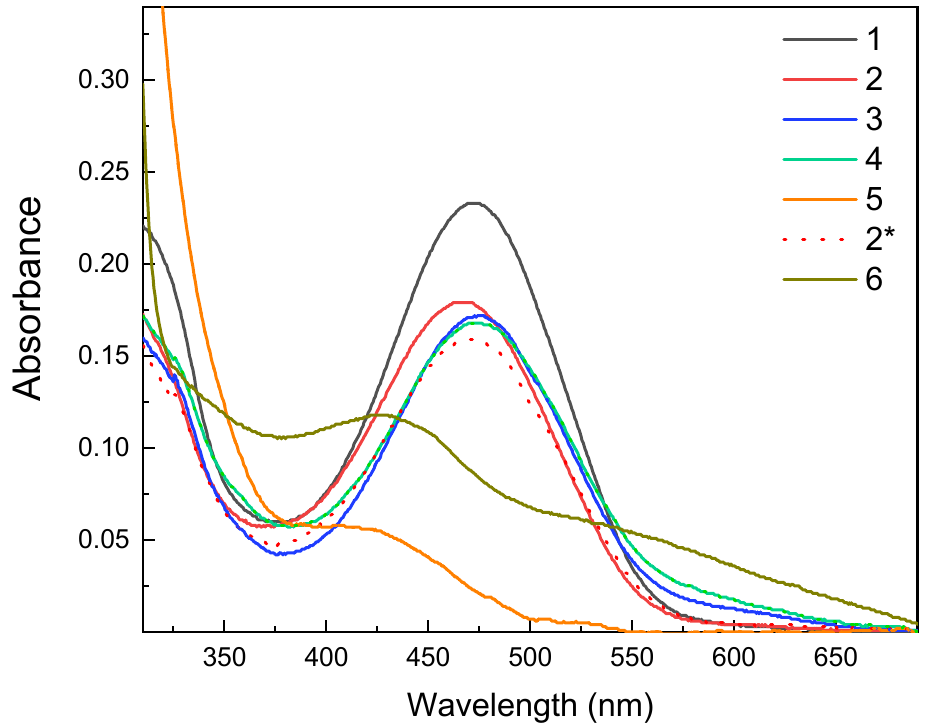
Figure 5. UV-Vis absorption spectra of AL embedded in SVE-FPBA micelles (curve 1) and changes in the spectrum immediately after addition of HCl (curve 2), galactose (curve 3), fructose (curve 4) and ascorbic acid (curve 5). Curve 2* shows the spectrum 72 h after addition of HCl. Curve 6 shows UV-Vis absorption spectrum of AL in aqueous solution of ascorbic acid.